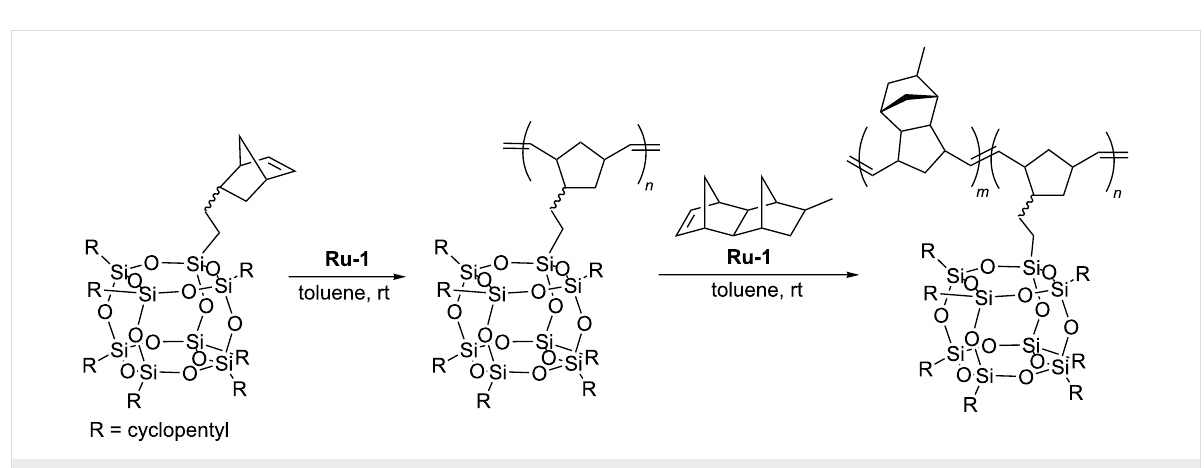
Scheme 26: Ring-opening metathesis copolymerization of POSS-NBE with methyltetracyclododecene.